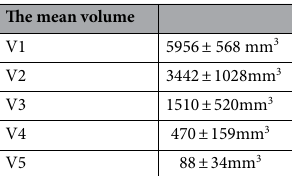
Table 3. Mean volume of orbital retrobulbar segments. This table demonstrates the measured volume of each segment V1–V5 of the orbital retrobulbar